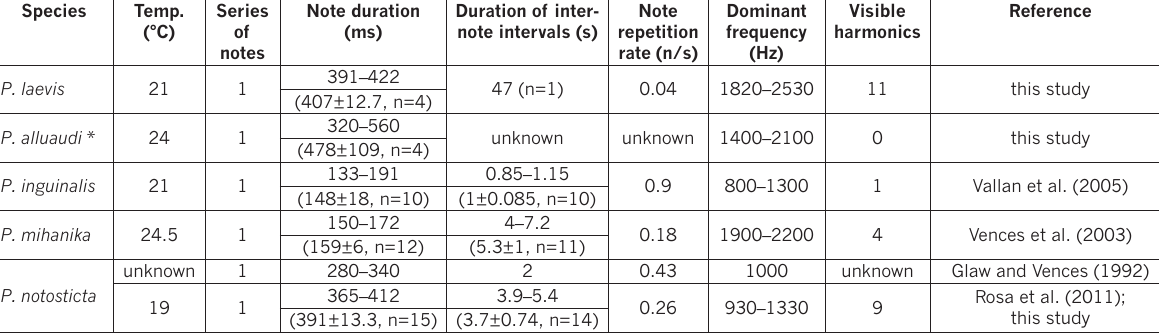
Table 3. Comparative measurements from advertisement calls of Plethodontohyla species. Species Temp. Series Note duration Duration of inter- (°C) of (ms) note intervals (s) notes